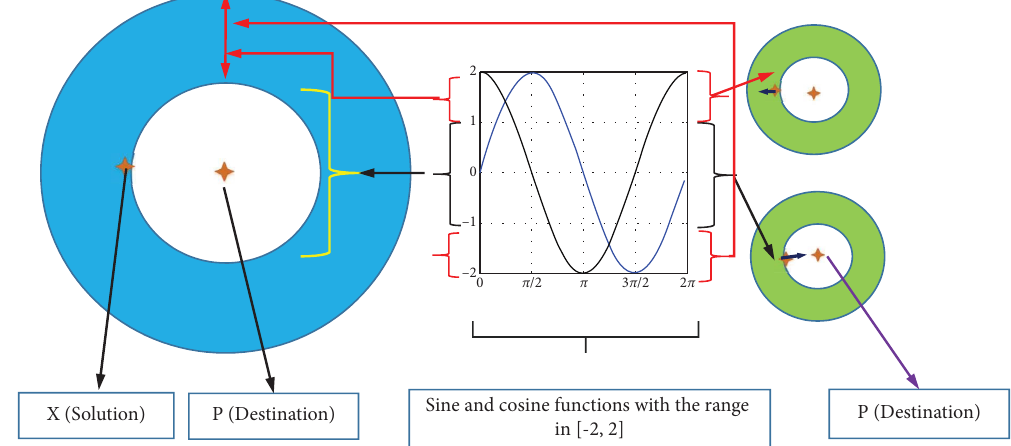
Figure 3: Efects of the function in the range ( − 2, 2) enabling a solution to go outside or around the destination [42, 43].